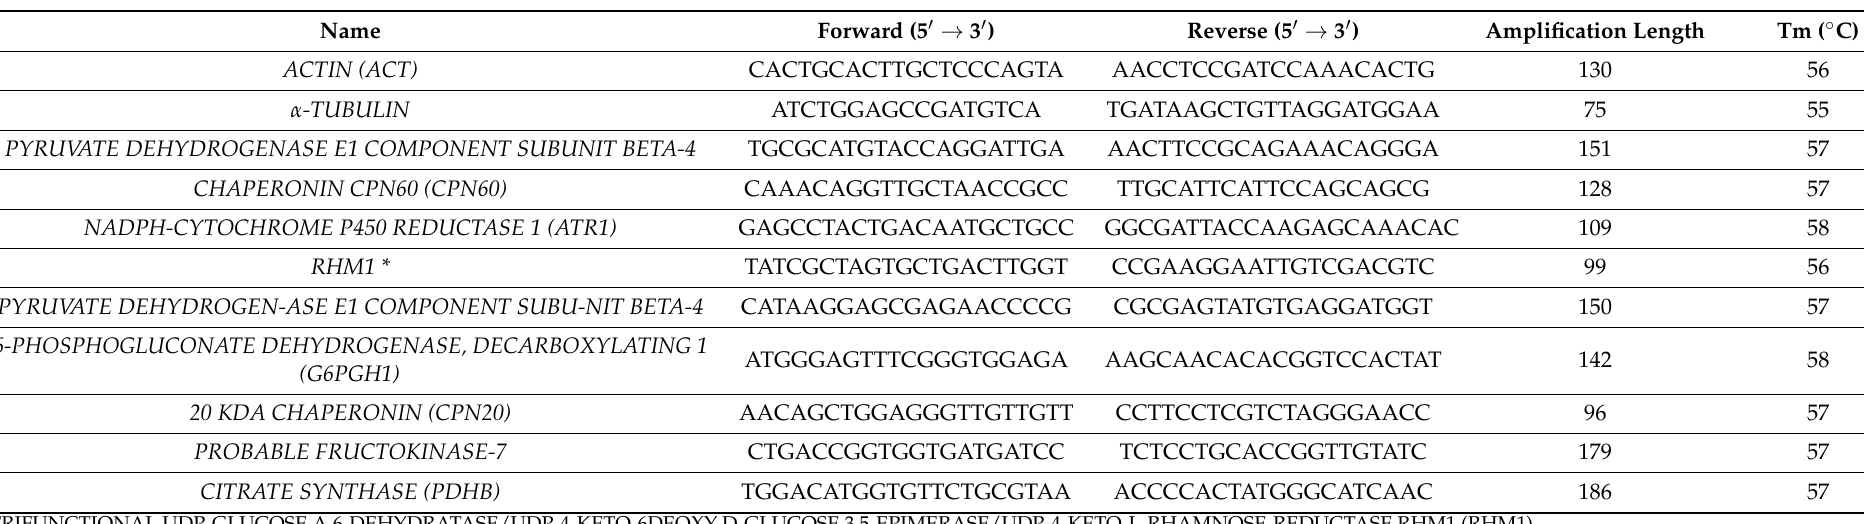
Table 4. List of primers used in quantitative reverse transcription PCR (RT-qPCR) for relative expression analysis. Name of transcript, forward and reverse primer sequences, amplification length and melting temperatures of primers are